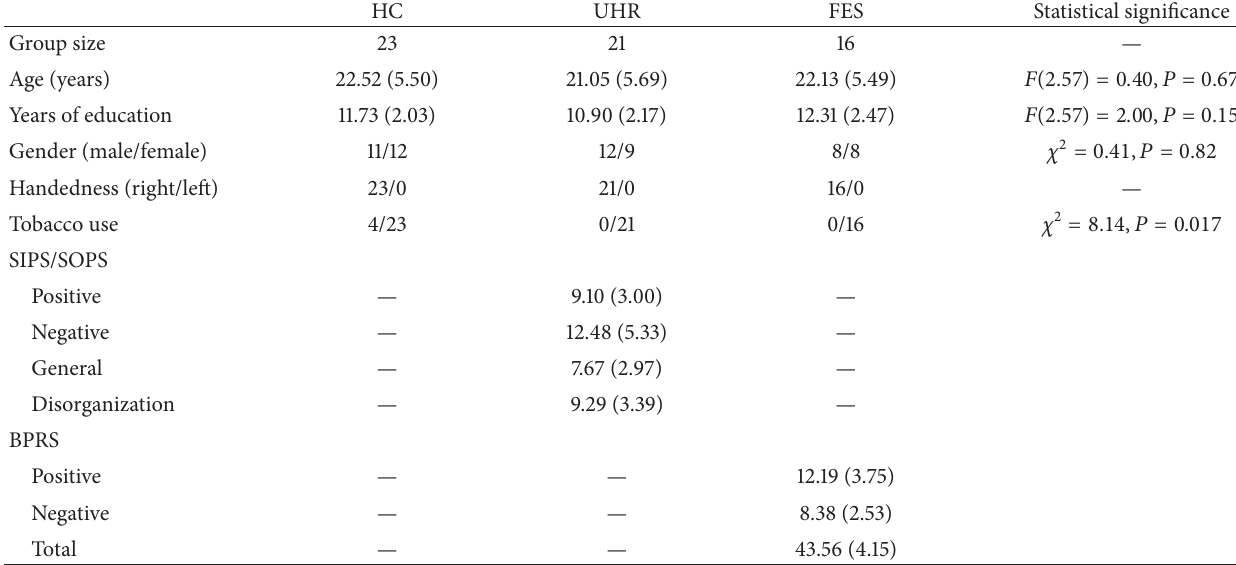
Table 1: Demographic and clinical characteristics among patients with first-episode schizophrenia (FES), subjects at ultrahigh risk for psychosis (UHR), and healthy controls (HC).